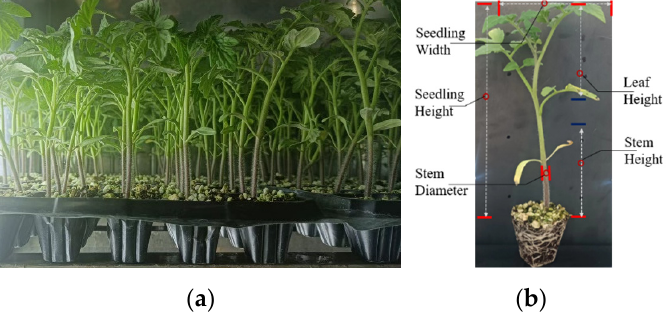
Figure 1. Transplanting object. ( a ) Seedling tray; ( b ) seedling morphology.